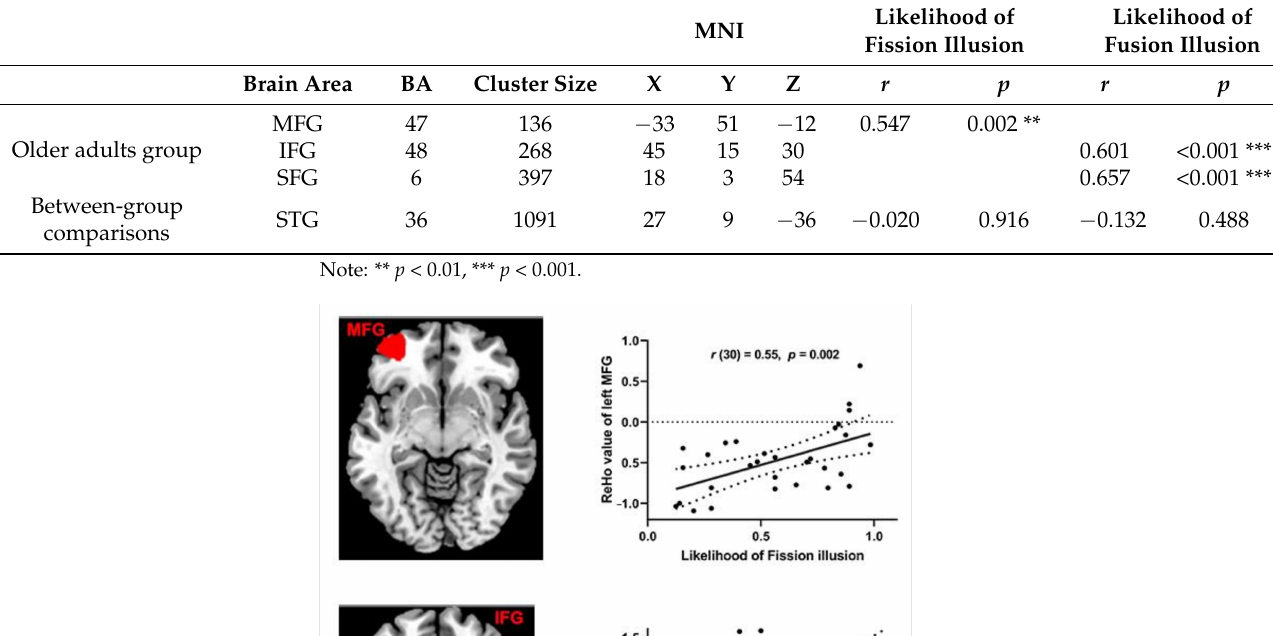
Likelihood of MNI